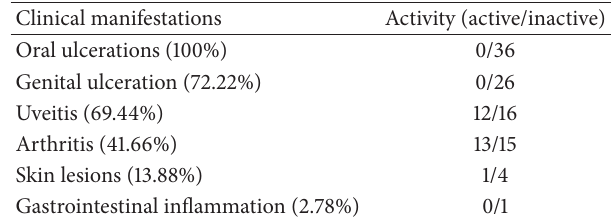
Table 1: Patients’ clinical